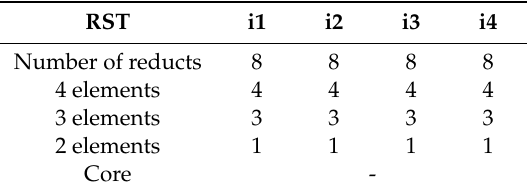
Table 8. Number, size, and cores of reducts designated using the RST method for the selection of road sections to the scale of